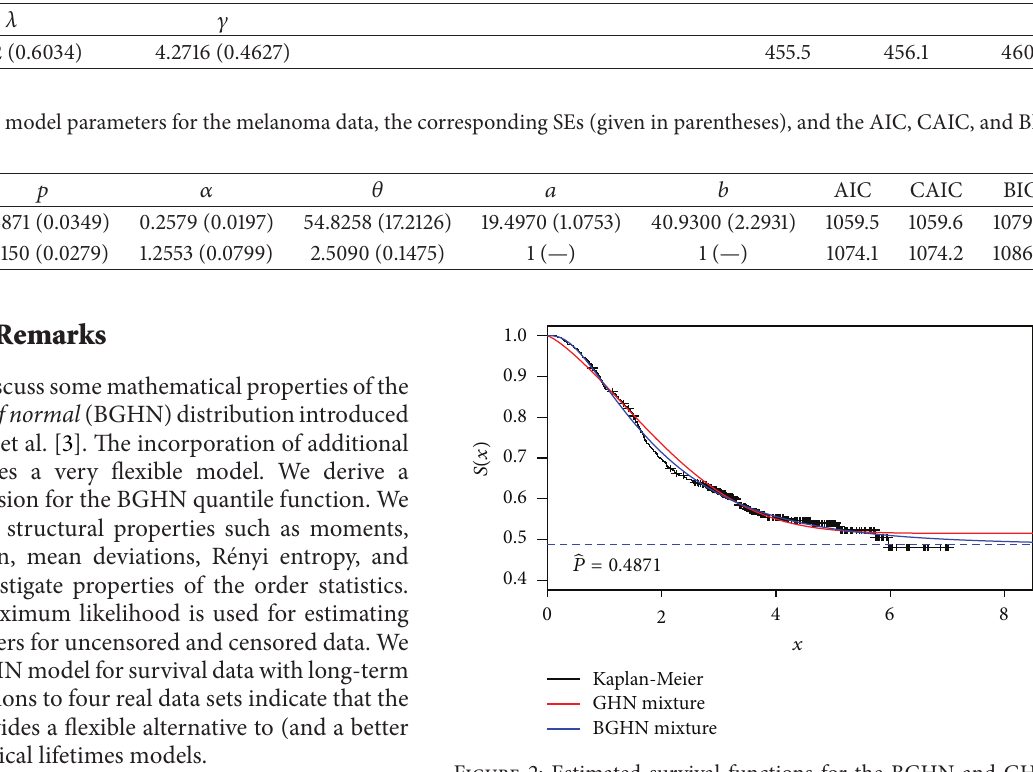
Figure 2: Estimated survival functions for the BGHN and GHN mixture models and the empirical survival for the melanoma